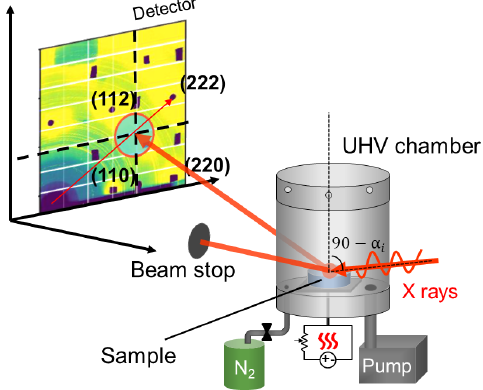
FIG. 1. Schematic of the GIXRD setup. The high-energy x-ray beam falls on the sample surface at grazing incident angle α i , and the diffraction patterns are obtained by a 2D detector while the sample undergoes different annealing treatments under UHV and N 2 . The blue circle represents the position of the interstitial diffuse scattering along the [111] direction (red line), while Nb reflections, indexed by their hkl values, are blocked with lead pieces to locally protect the detector. In order to sample 3D reciprocal space, the sample is typically rotated around its surface normal (dashed line), and at each angular position a diffraction pattern is